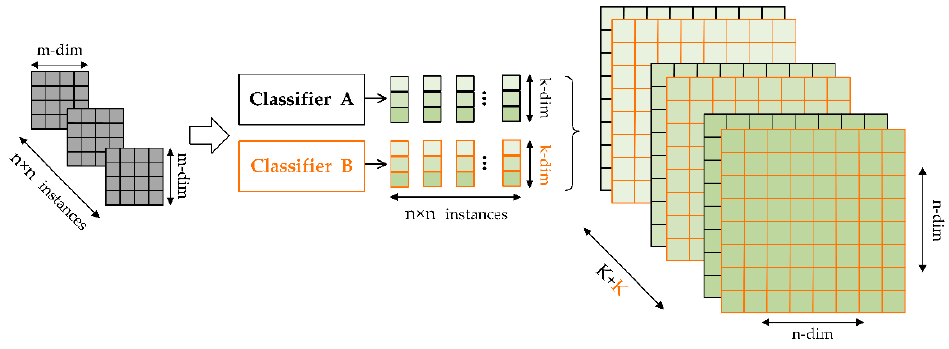
Figure 2. The formation and transformation of second-stage features vectors.